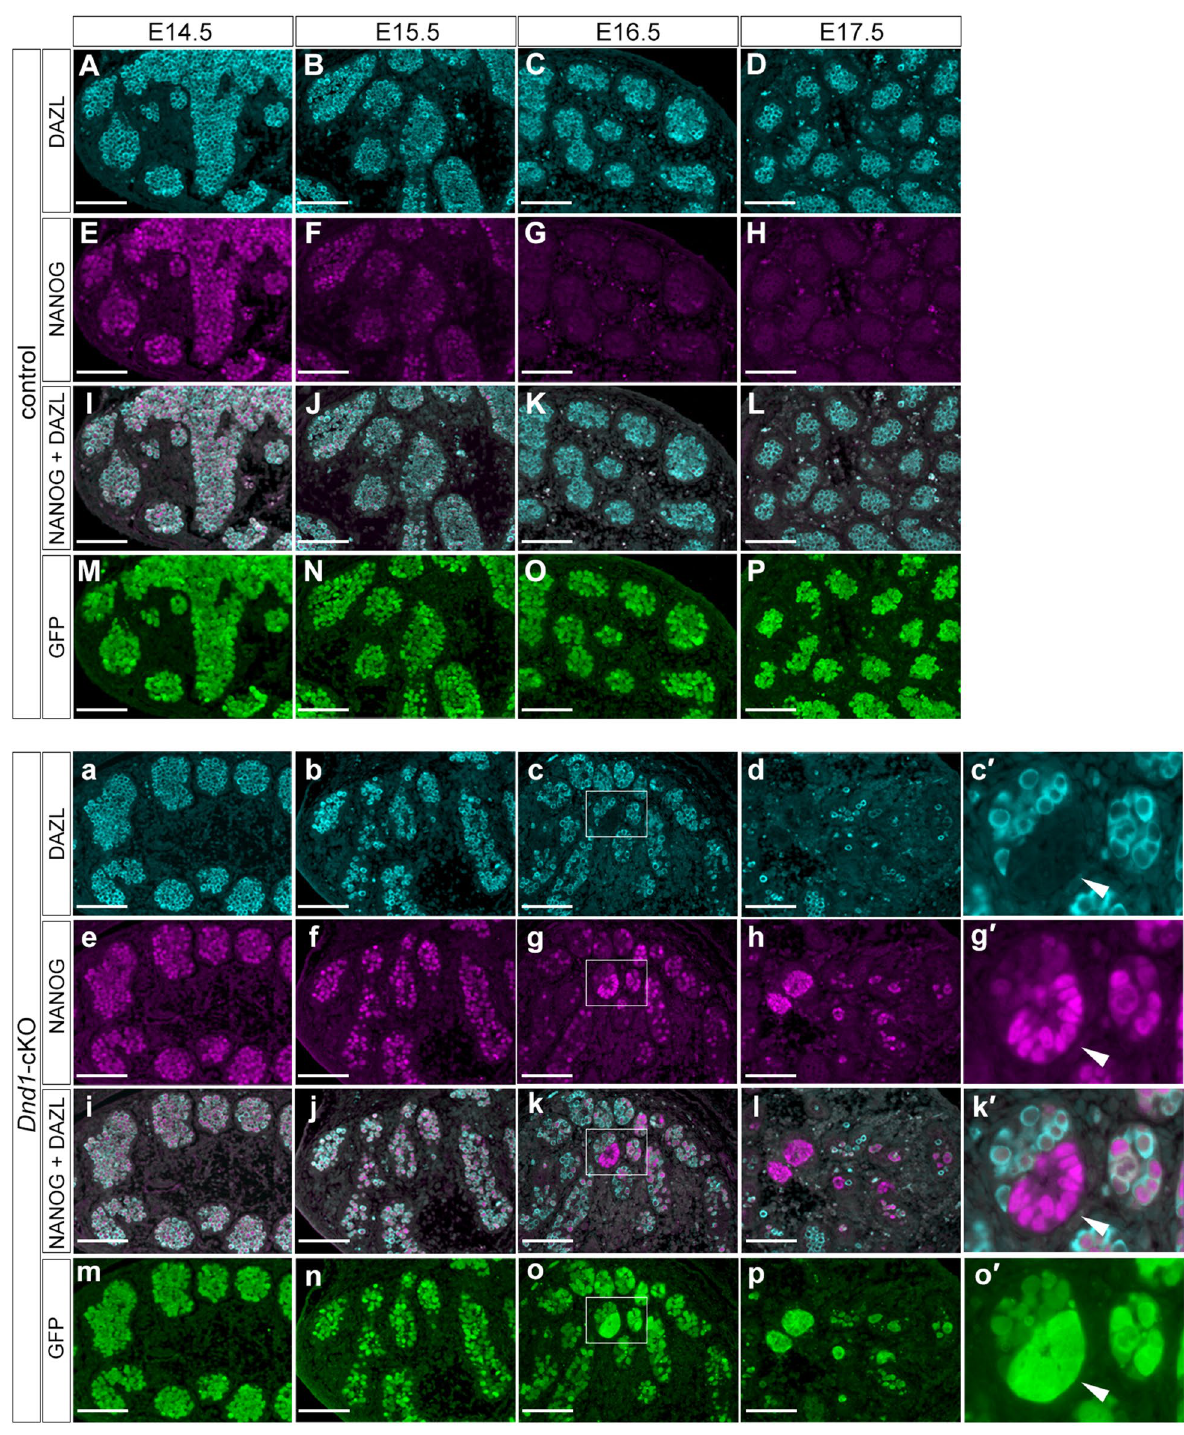
Figure 3. ECCs develop from a fraction of PGCs after E16.5 in Dnd1- cKO testes. ( A – p ), Testis sections from the control ( Dnd1 flox/flox ; Nanog-GFP ) ( A – P ) and Dnd1 -cKO ( Dnd1 flox/flox ; Nanog-GFP; Rosa26-CreER T2 ) ( a – p ) embryos at E14.5, E15.5, E16.5, and E17.5, were immunostained with antibodies against DAZL ( A – D , a – d ), NANOG ( E – H , e – h ), and GFP ( M – P , m – p ). Merged images of DAZL and NANOG are shown in ( I – L ) and ( i – l ), respectively. Enlarged views of the area enclosed by rectangles in ( c , g , k ), and ( o ) are shown in ( c ′ , g ′ , k ′ ), and ( o ′ ), respectively, to better visualise the expression of each protein. Images correspond to one of n > 3 biological replicates. Arrowheads in ( c ′ , g ′ , k ′ ), and ( o ′ ) indicate a ECC colony. Scale bars: 100